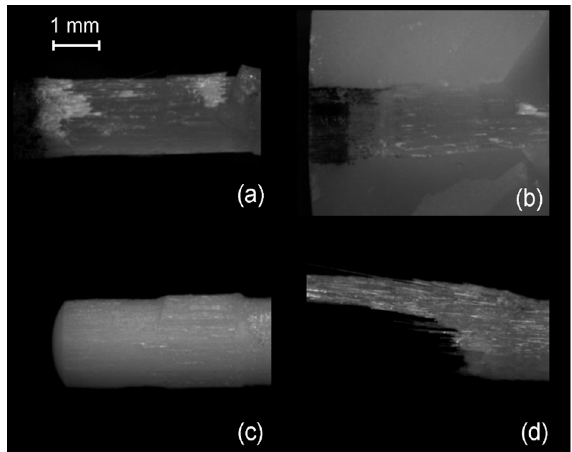
Figure 7. Stereomicroscopic images of fractured posts and core build-up materials (25×, bar = 1 mm). ( a ) FBK coronal part with broken serrations; ( b ) FBK broken part into the core material; ( c ) PRW with sheared off spherical retentive elements; ( d ) ARL body fracture.